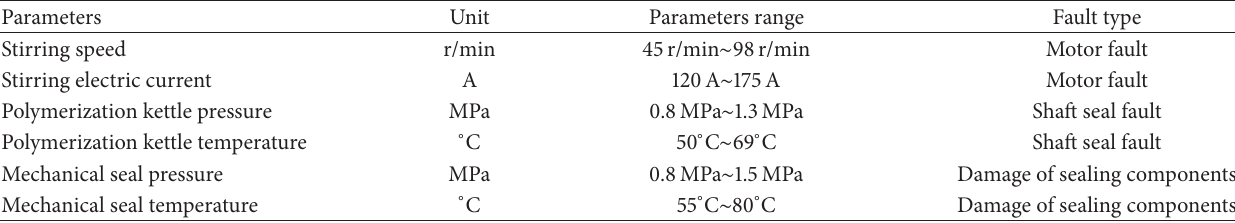
Table 1: Main parameters of polymerization kettle.